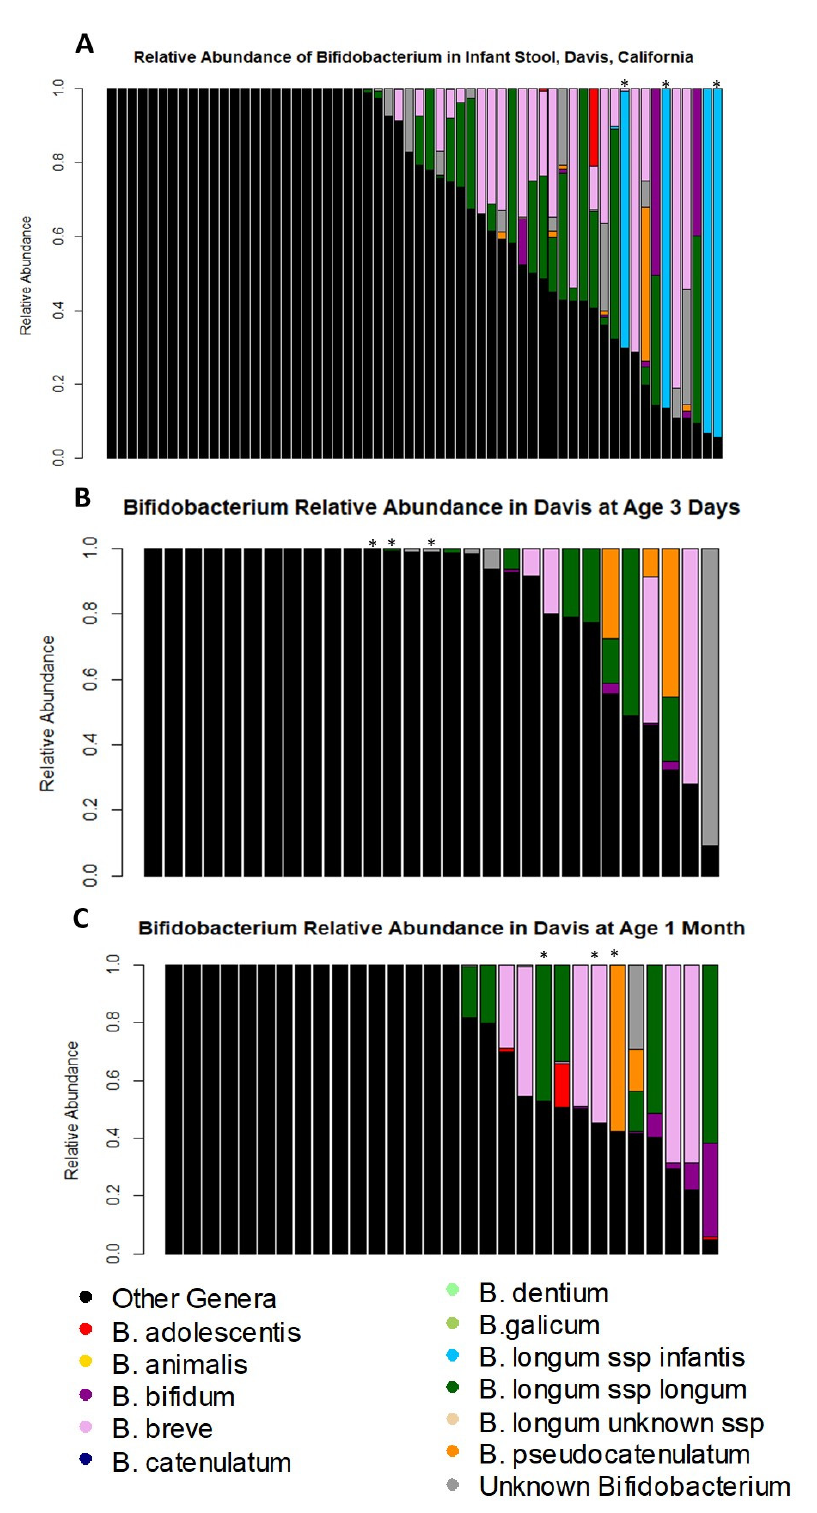
Figure 3. Bifidobacterium colonization in Davis, CA infants over time. Each bar represents the microbiome of a single infant. Stars indicate samples from infants who were colonized by B. longum subsp. infantis at age 2 months with longitudinal samples. ( A ) 2 months of age samples (repeated from Figure 2); ( B ) 3 days of age; ( C ) 1 month of age.